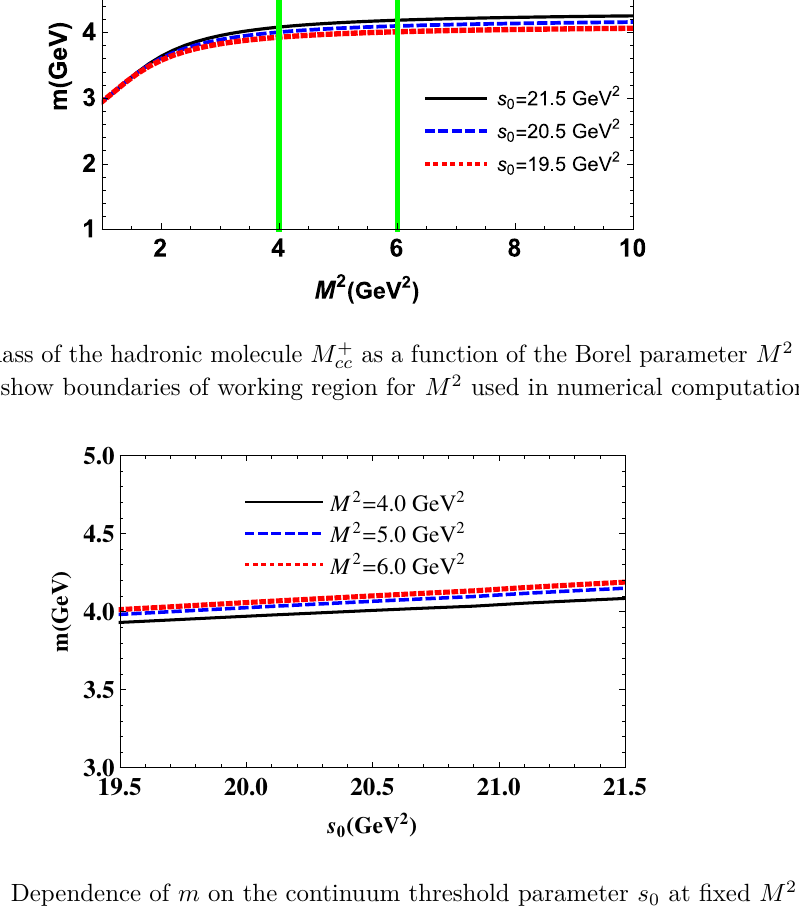
Figure 2 . Dependence of m on the continuum threshold parameter s 0 at fixed M 2